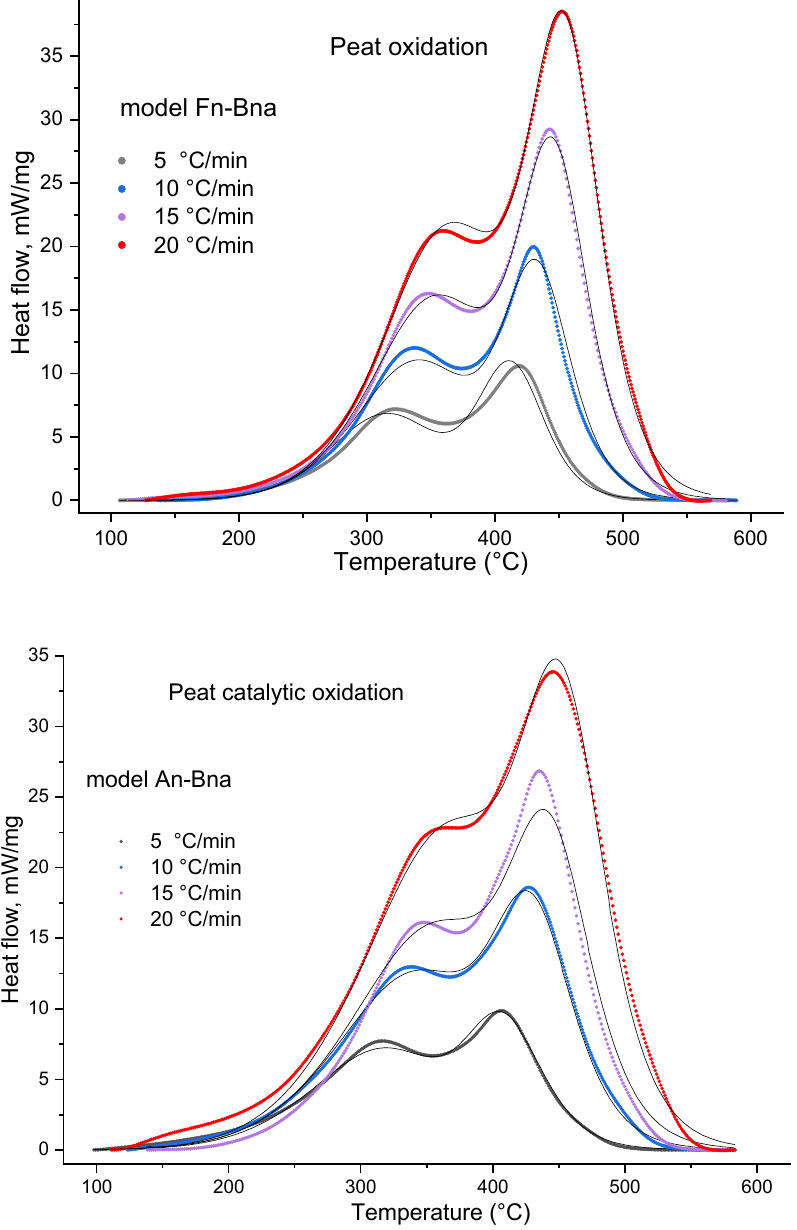
Figure 7. DSC model curves of peat oxidation in the presence and absence of iron tallate.